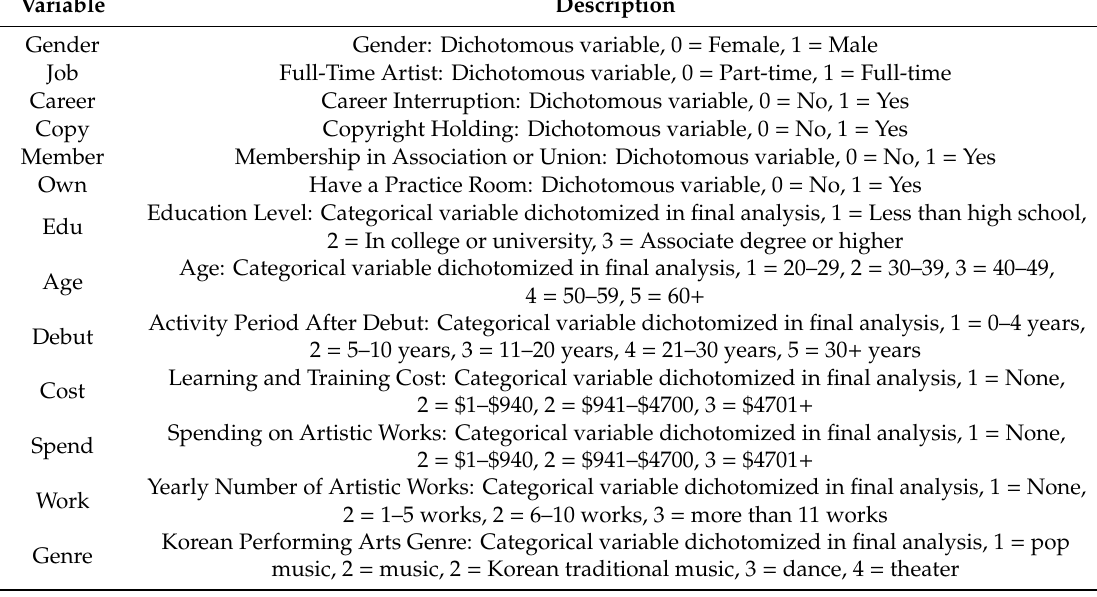
Table 1. List of independent